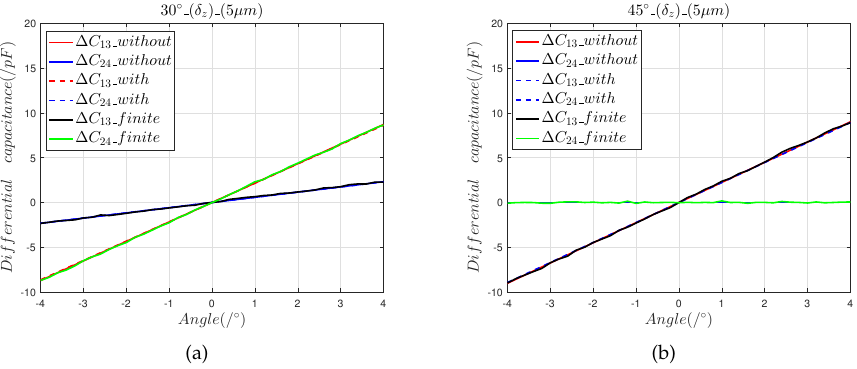
Figure 6. The 5 µ m radial installation error analysis: (a) differential capacitance in the 30° direction; (b) output capacitance in the 45° direction.